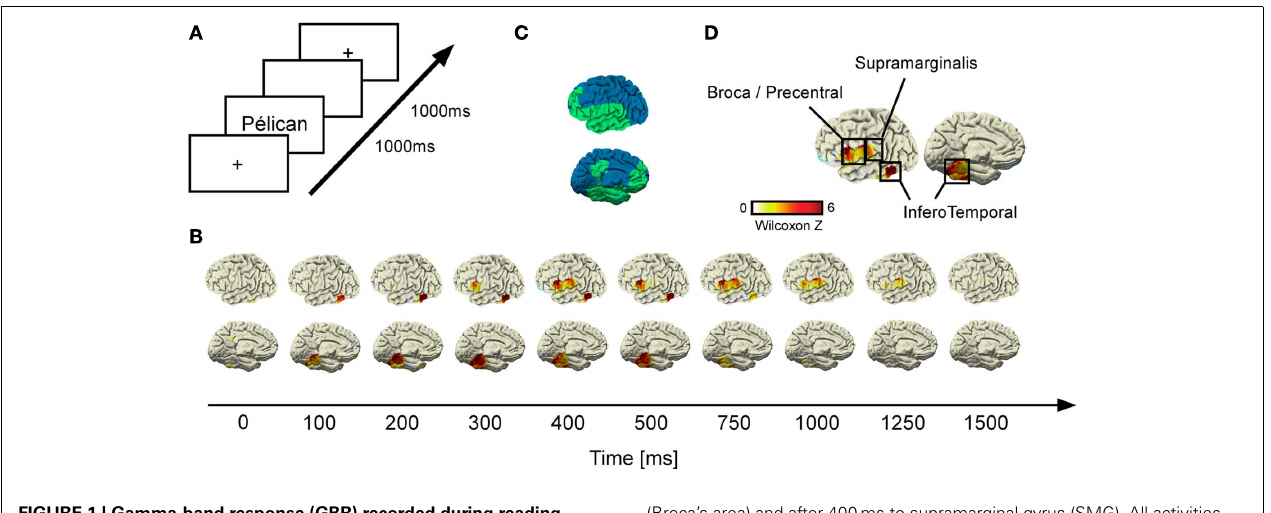
FIGURE 1 | Gamma-band response (GBR) recorded during reading across conditions. (A) Shows details of the experimental design; (B) illustrates grand-average statistical response (Wilcoxon Z ) of GBR vs. baseline recorded by each electrode across time for each patient. After the stimulus onset, the inferior temporo-occipital cortex (ITOC) elicits early GBR which propagates after 300ms to inferior frontal gyrus